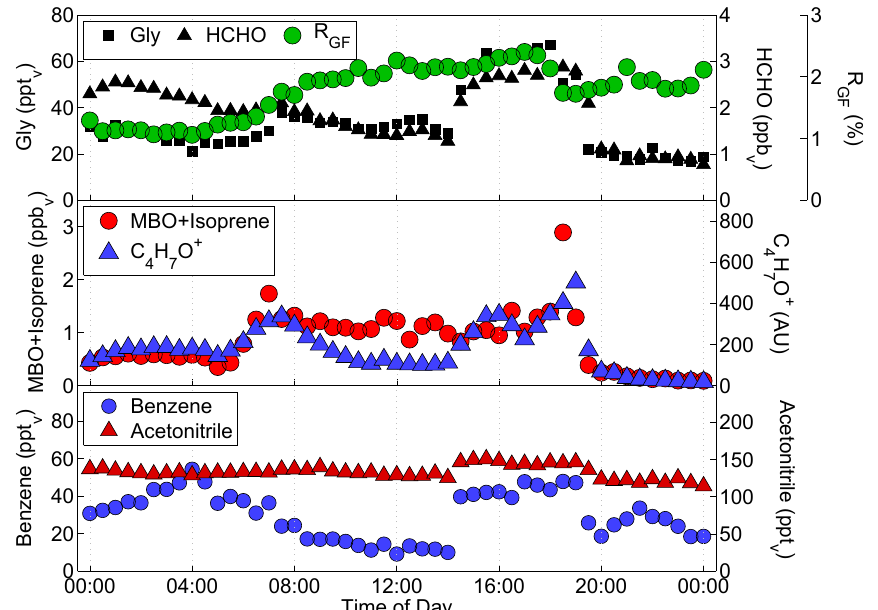
Fig. 4. Gly, HCHO, R GF and other tracer species during day BN2 (DOY 231). Gly, HCHO, and R GF are shown as 30 min binned averages ( ± 15 min each half hour), whereas other species are shown at full resolution. Data for MBO+Isoprene, C 4 H 7 O + , benzene, and acetonitrile were measured via